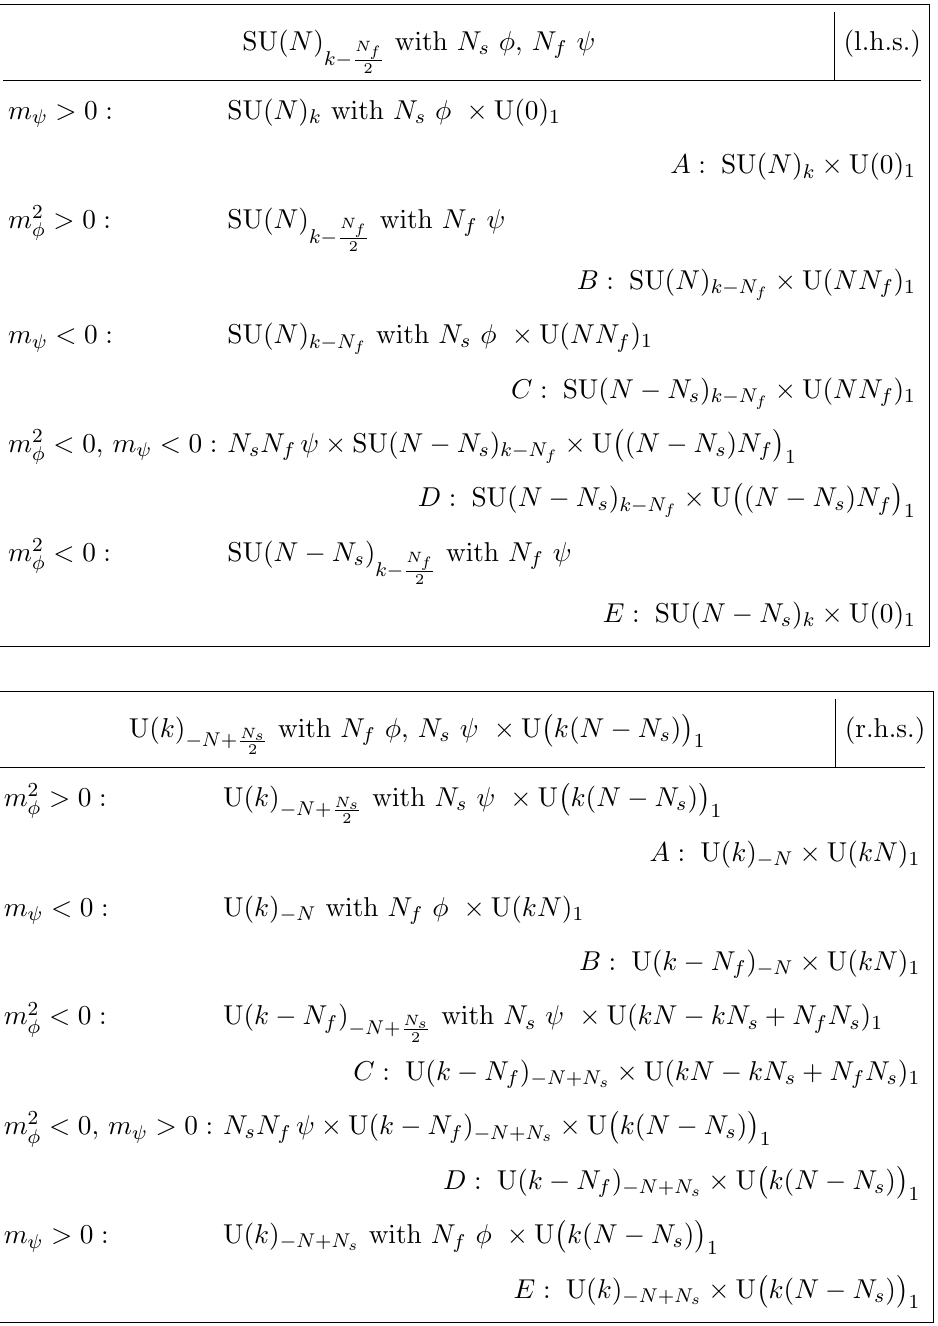
Table 1 . Phase diagram of the SU / U dualities, for N > N s and k